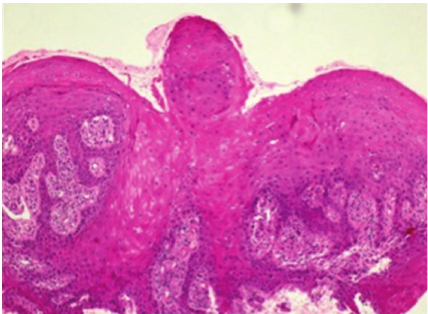
Figure 2: Verrucous lesion extension mainly located on the left side of both soft and hard palate (H and E 200x).